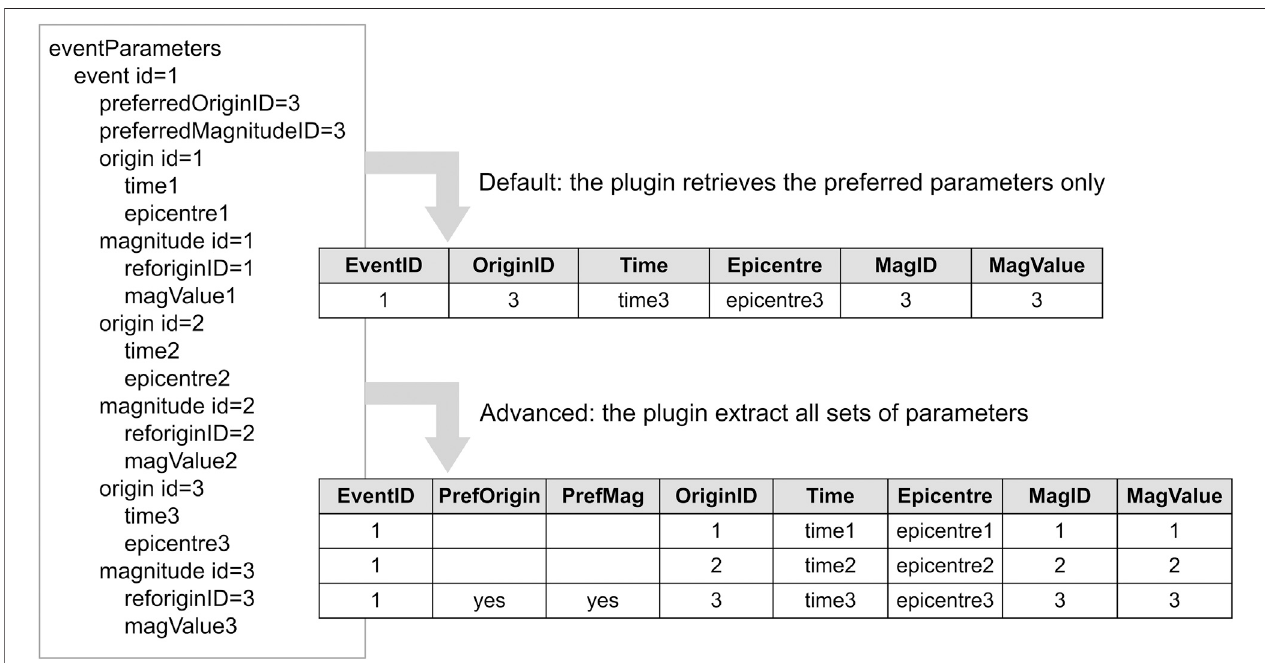
FIGURE 3 | Reprocessing of the input QuakeML for compiling the output table associated with the GIS layer.